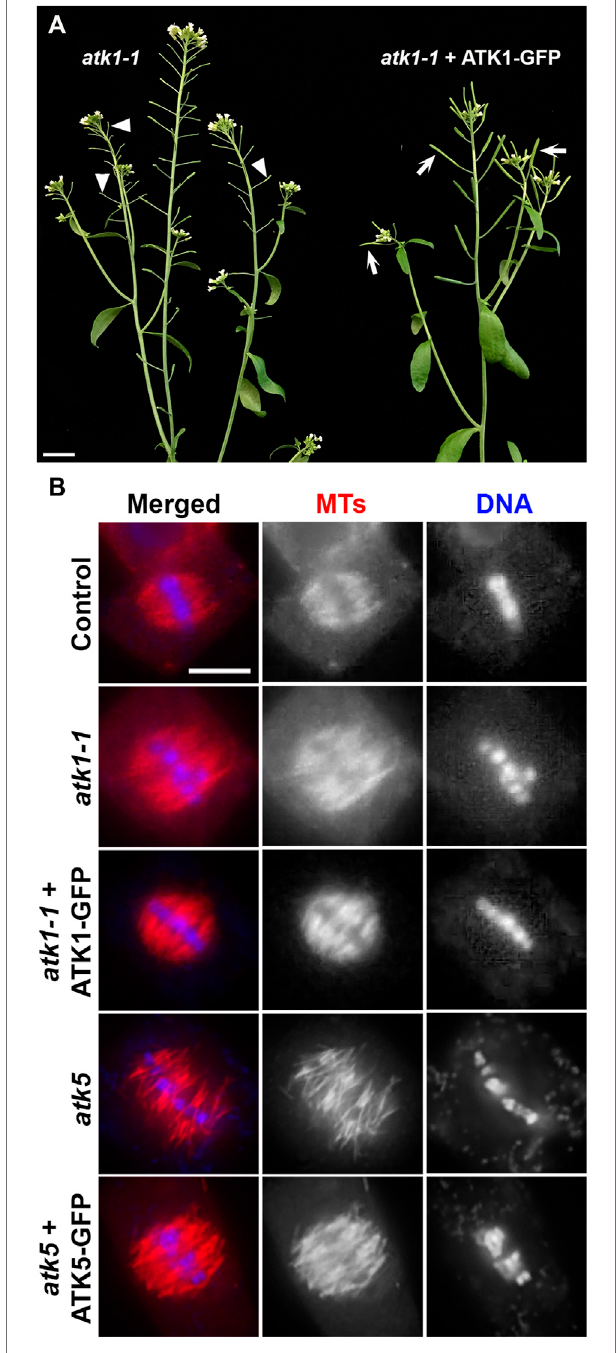
FIGURE 1 | GFP fusion proteins of ATK1 and ATK5 function in spindle MT organization in A . thaliana . (A) Male sterile phenotype, re fl ected by unelongated siliques (arrowheads), is suppressed by the expression of the ATK1-GFP fusion protein that resulted in the production of seed- fi lled siliques (arrows). (B) Spindle MT organization by anti-tubulin immuno fl uorescence in the atk1-1 mutant and the mutant expressing ATK1-GFP, atk5, and the atk5 mutant expressing the ATK5-GFP fusion. Both atk1-1 and atk5 mutants produced metaphase spindles thatdonotshowobviousspindlepolesandlackpolewardMTconvergence.Similar tothewild-typecontrol,theexpressionsofATK1-GFPandATK5-GFP,respectively, restored the fusiform spindle morphology. Scale bars, 1 cm (A) and 5 µm (B) .